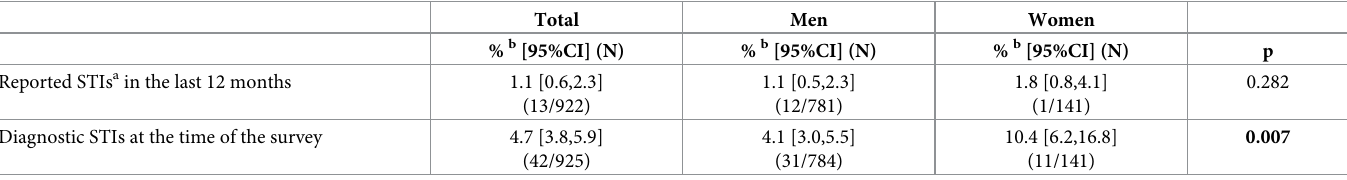
Table 3. Prevalence of STIs among French service members, according to gender, and according to the origin of information (reported versus biologically con- firmed (diagnostic STIs)), COSEMIL survey.